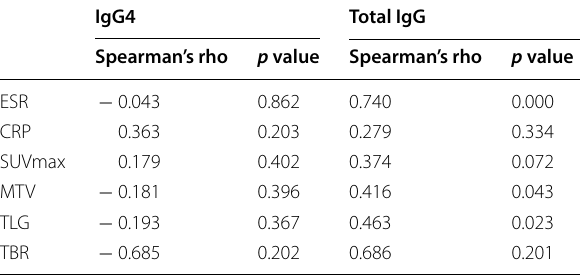
Table 4 Correlation between serum immunoglobulins vs inflammatory markers and semi‑quantitative